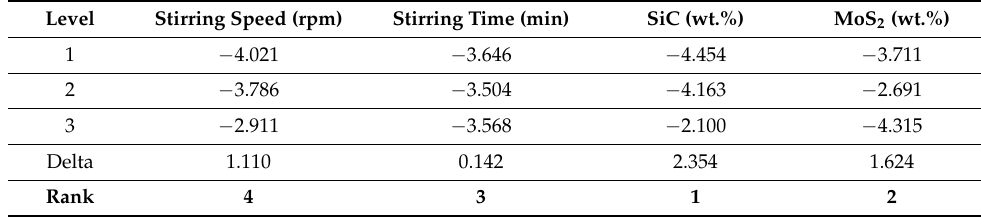
Table 14. Signal-to-noise ratio for GRG for larger is